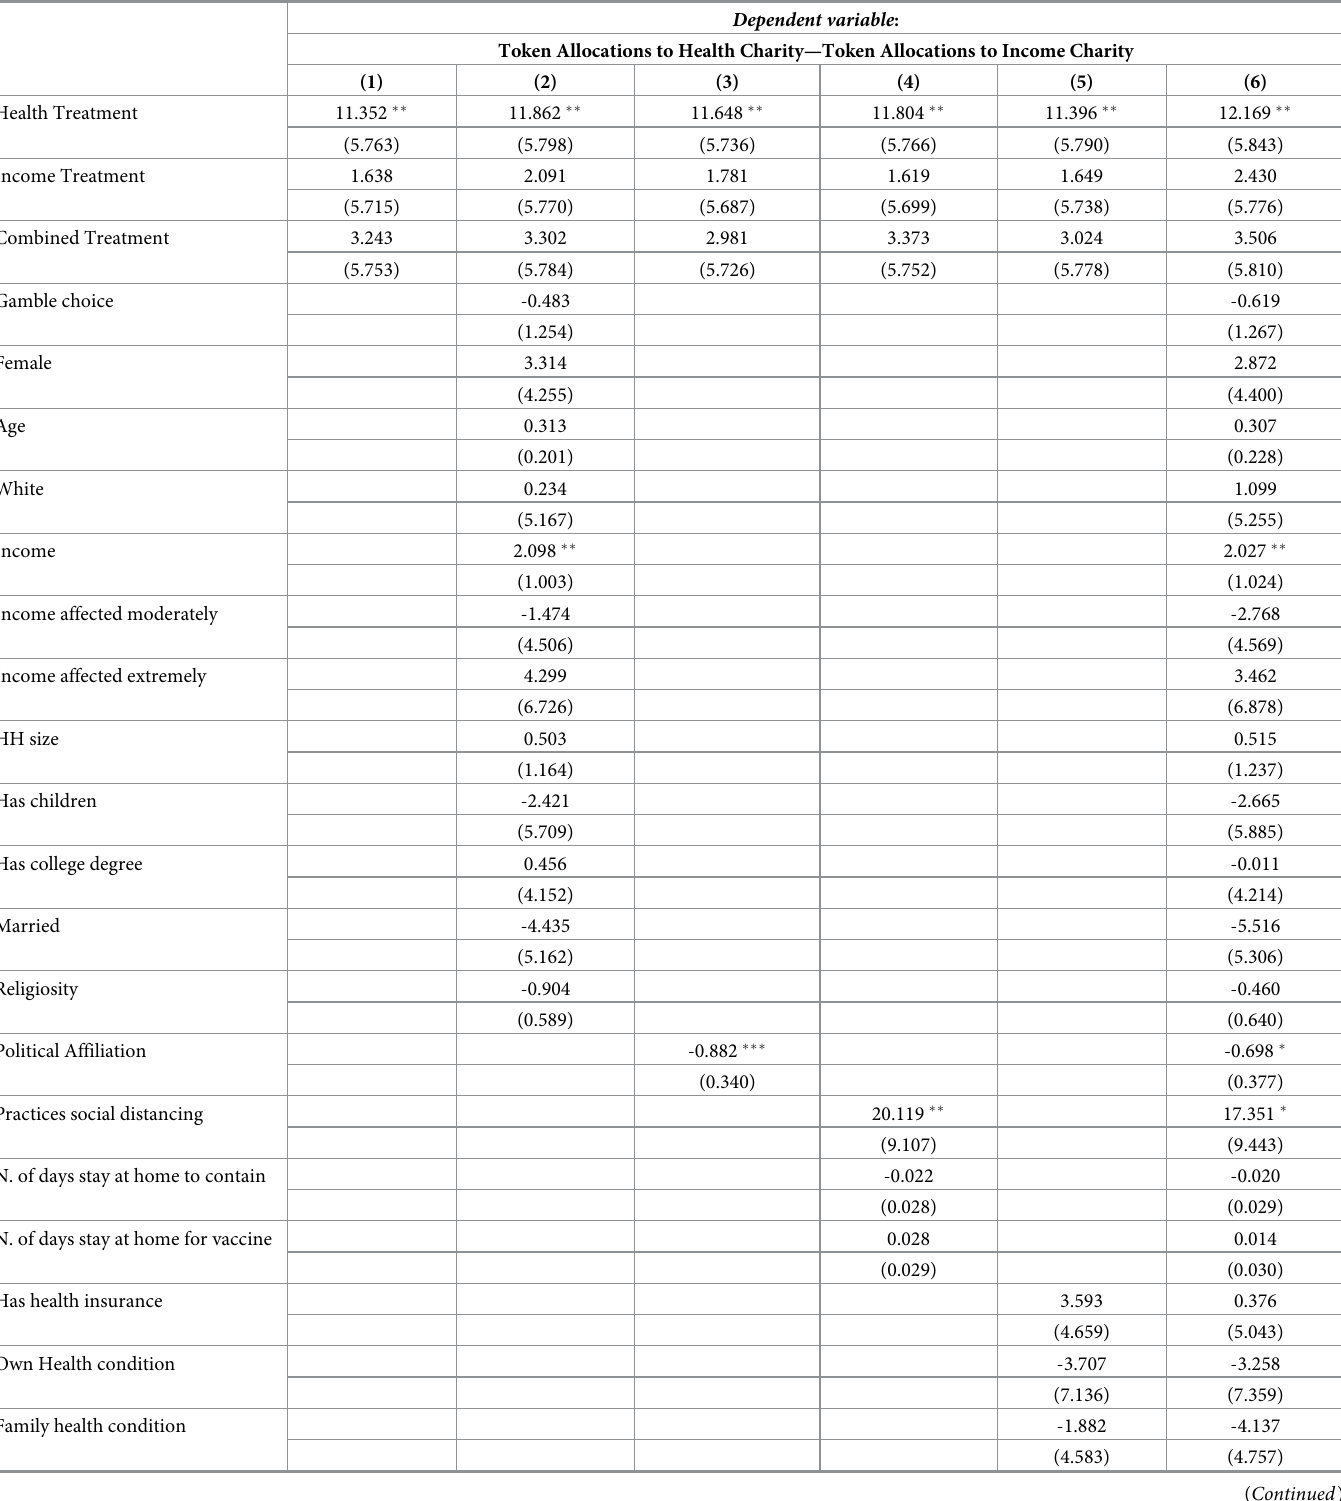
Table 1. The relationship between differential token allocations to the health charity and individual characteristics.